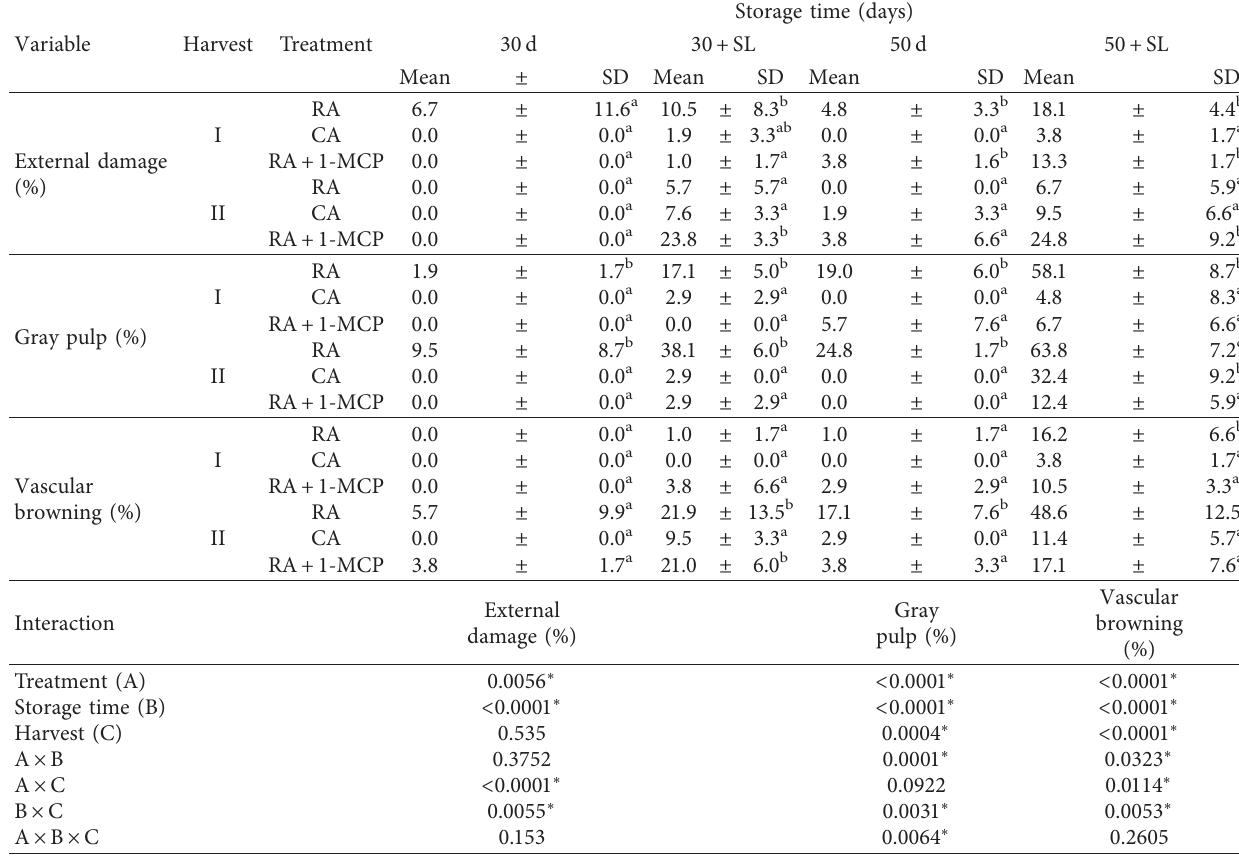
Table 8: Evaluation of physiological disorders in “Fuerte” avocado under different storage conditions for 30 and 50 days at 5 ° C. RA: regular air (85% relative humidity); CA: controlled atmosphere (4% O 2 +6% CO 2 ); 1-MCP: 1-methylcyclopropene (300 ppb); s.d: standard de- viation. I: early maturity stage; II: advanced maturity stage. D: days at 5 ° C. SL (shelf life): fruit storage at 20 ° C. Fruit at SL was evaluated at the same flesh firmness level. Each value corresponds to mean of 35 fruits. Different letters within each storage time and harvest represent significant differences at as determined by the LSD